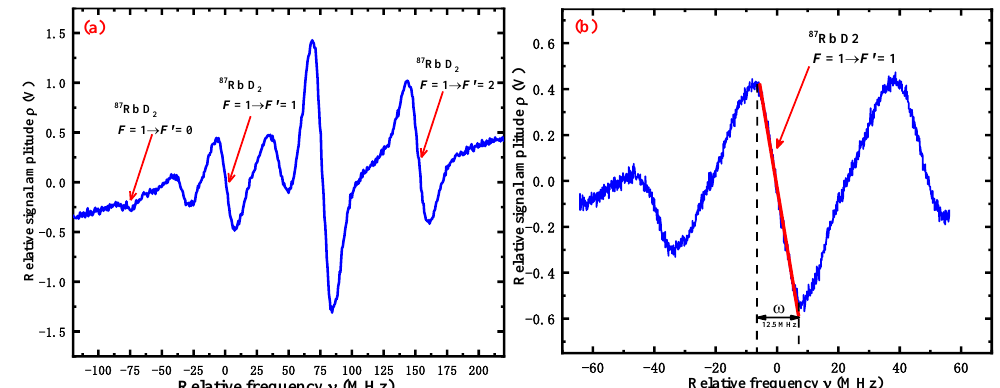
200-1.5 -100 -75 -50 -25 0 25 50 75 100 125 150 175 Figure 2. The results of the demodulated dispersive signal of FMS. ( a ): The measurement of the dispersive curve of the 87 Rb D2 line F = 1 → F ′ = 0, F ′ = 1, F ′ = 2. ( b ): The measurement of the dispersive curve of the 87 Rb D2 line F = 1 → F (cid:48) = 1, and the red line with the slope γ = − 0.07959 V/MHz is the linear fitting of the side of the F = 1 → F (cid:48) = 1, and the modulation frequency ω = 12.5 MHz. The frequency-locking noise δν is defined by δν = δρ / γ . Therefore, the